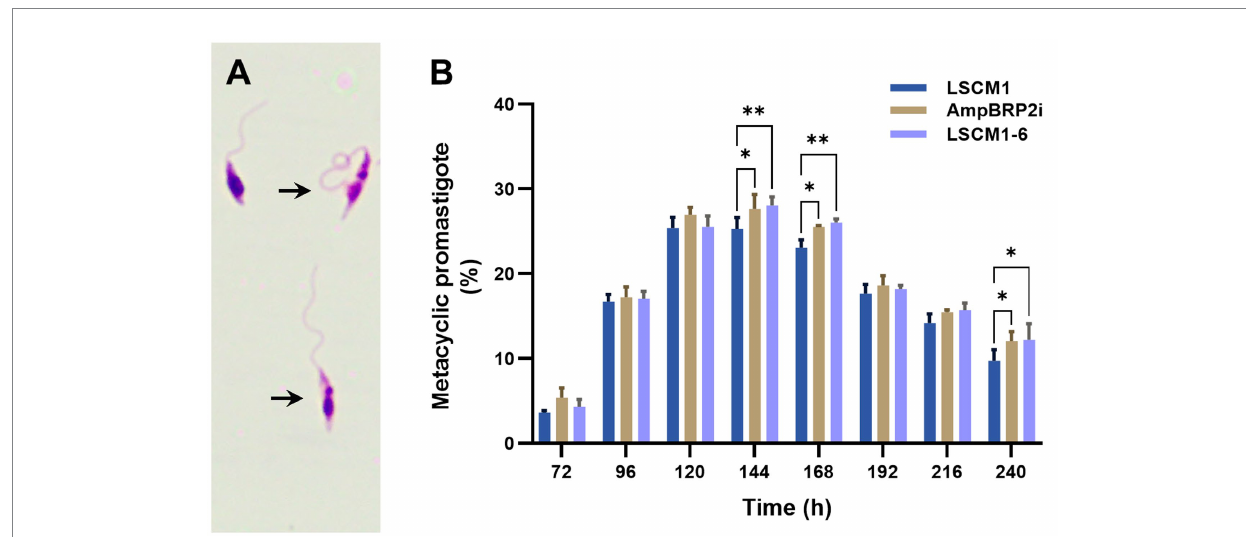
FIGURE 3 (A) Metacyclic promastigotes of L. martiniquensis (arrows). (B) Metacyclogenesis of the LSCM1, AmpBRP2i, and LSCM1-6 promastigotes. Morphometric analysis was conducted by microscopy using the criteria defined by Chanmol et al. (2019) from 72 to 240 h of culture. Statistically significant differences among the three groups are indicated as follows: ** = p < 0.01; and * = p <